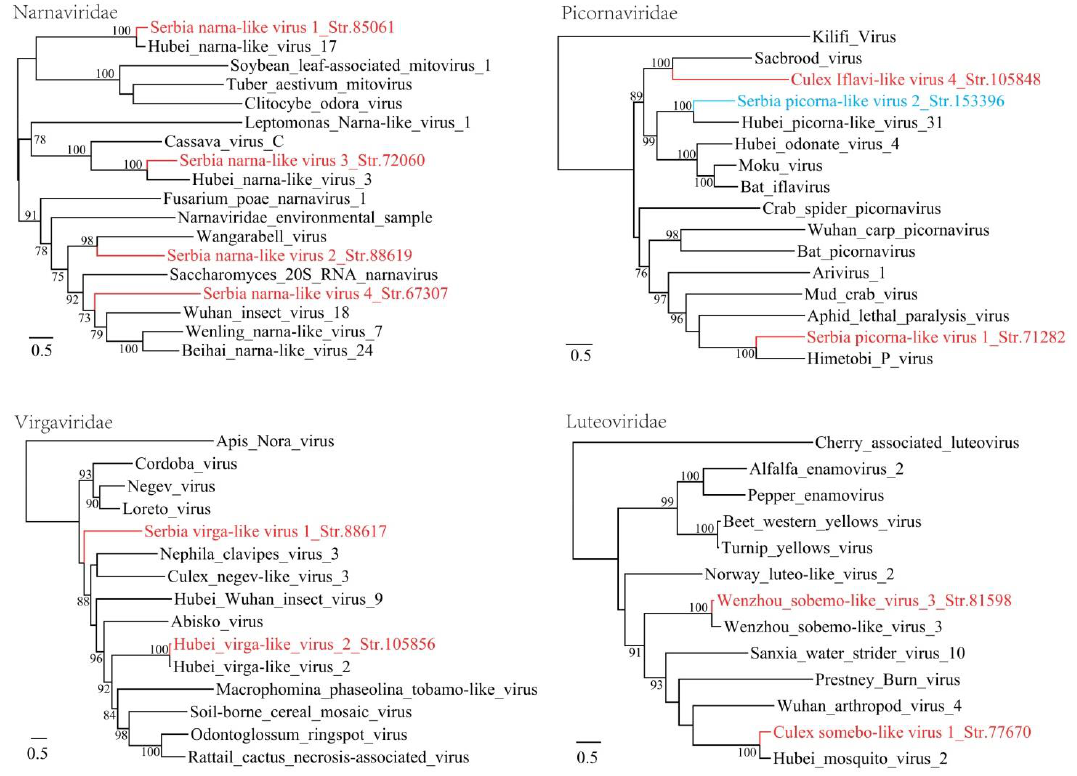
Figure 2. Phylogenetic analysis of +ssRNA viruses including Narnaviridae, Picornaviridae, Virgaviridae and Luteoviridae. The phylogenetic trees were inferred using the maximum likelihood (ML) method, with 1000 bootstrap replicates and mid-point rooting. Red: viruses from mosquitoes ( Culex Pipiens ), blue: virus from bedbugs ( Cimex lectularius ).